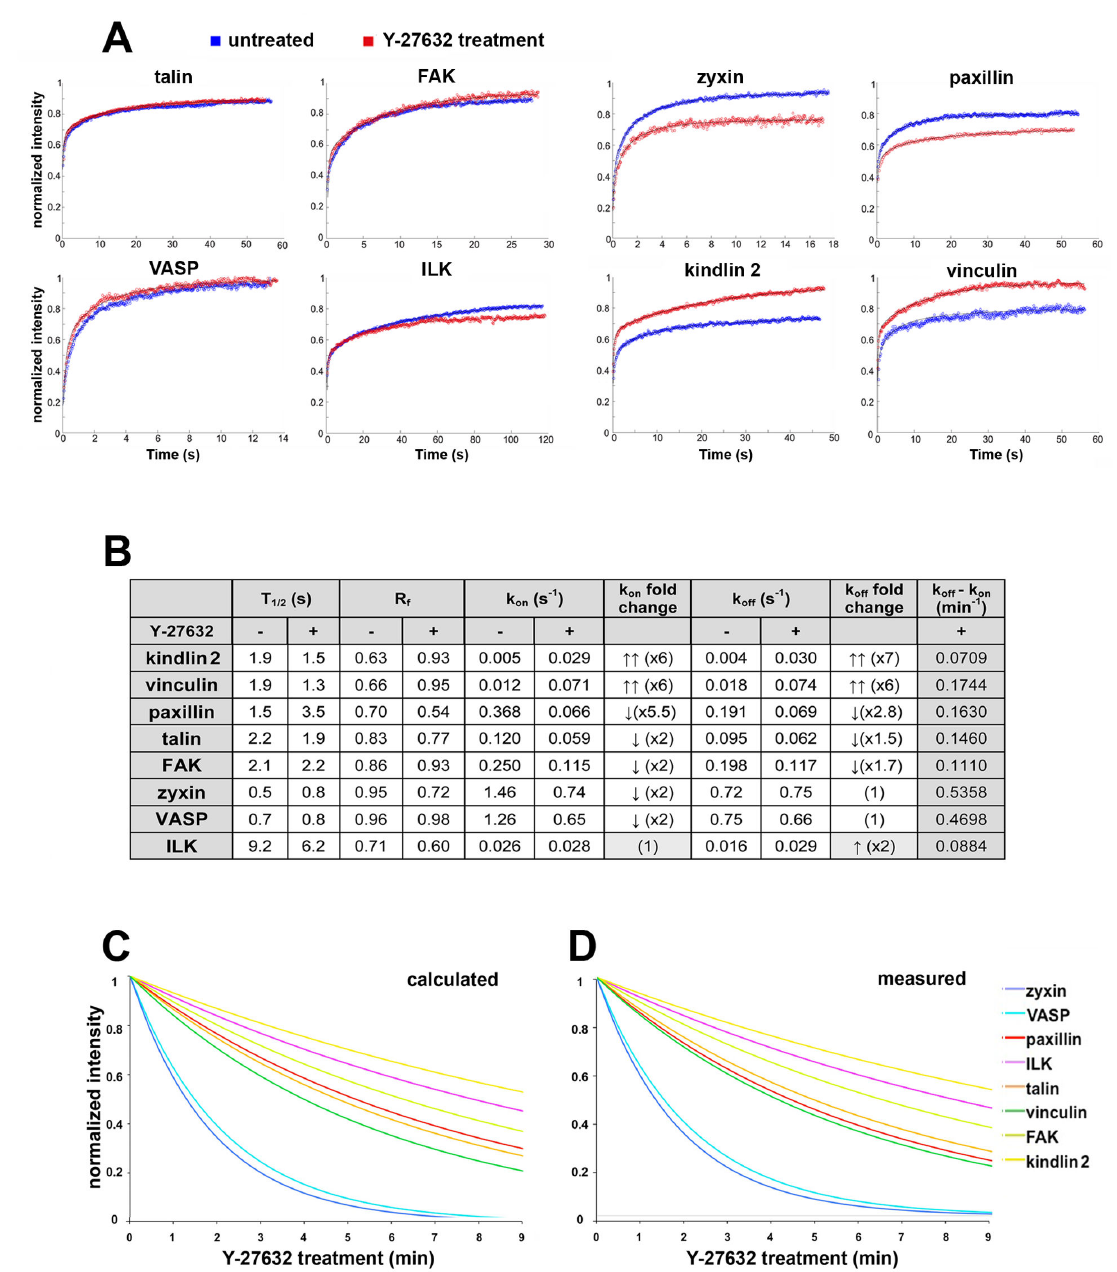
Figure 7. Dynamics of FA plaque proteins following Y-27632 treatment. ( A ) Normalized averaged FRAP curves (n=20-30) of FA plaque proteins in untreated and Y-27632 treated cells. For some proteins, no major changes were observed in the FRAP curves in untreated vs. treated cells (talin, FAK, VASP, ILK), whereas other proteins displayed higher (vinculin, kindlin-2) or lower (paxillin, zyxin) FRAP rates following Y-27632 treatment. ( B ) Kinetic parameters of FA proteins as derived from FRAP measurements within the first 9 min of Y-27632 treatment. The half-time to full recovery (T ) and mobile fraction (R ) values of the 1/2 f FRAP curves prior to and following Y-27632 treatment were not indicative of the overall FA disassembly state. However, the differences between the k and k values derived from fitting the FRAP data to the full diffusion-exchange model represent the on off disassembly rate of FAs for each protein, following Y-27632 treatment. ( C ) Theoretical FA disassembly curves calculated from the differences in the expected disassembly rates of tested proteins from the FRAP data. ( D ) Actual disassembly curves measured directly from time-lapse movies, following treatment of HeLa JW cells with Y-27632. Note the remarkable similarity between the calculated and measured values. doi: 10.1371/journal.pone.0073549.g007 PLOS ONE |